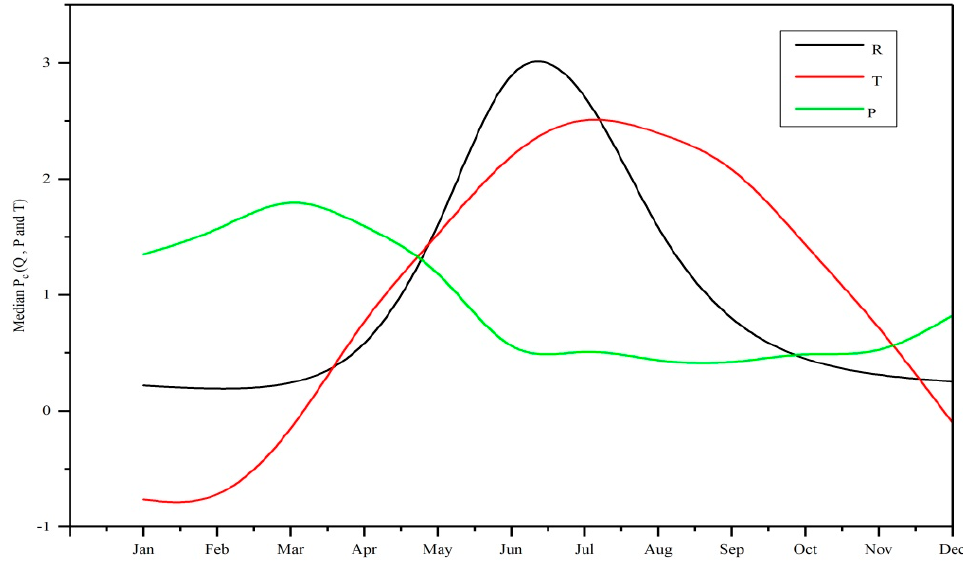
Figure 16. Comparison of di ff erent parameters of zone I. Figure 16. comparison of different parameters of zone I. Figure 16. comparison of different parameters of zone I.